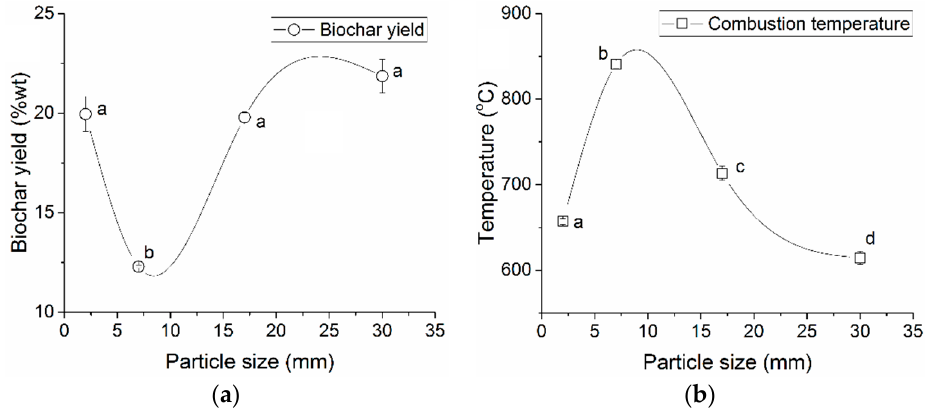
Figure 2. ( a ) The biochar yield and ( b ) combustion zone temperature of wood chips gasification at varying particles sizes (airflow 20 lpm, moisture content 10%, and biomass compactness 0 kg). Different letters on data points indicate significant differences ( p < 0.05).